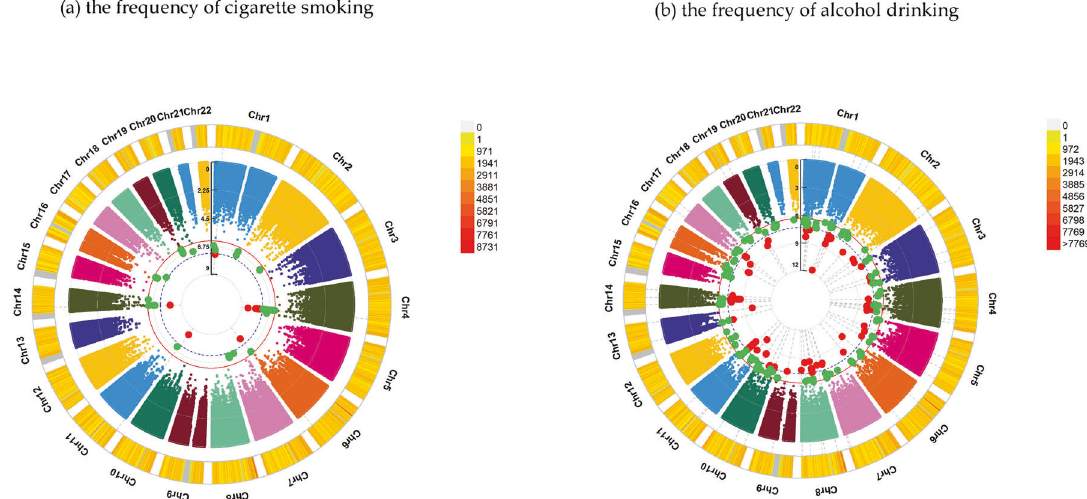
Fig. 3 Chromosomal regions interacting with felt loved as a child for substance use. *From the center, the circos depicts the − log 10 P values of each variant. Red plots represent the P value < 5 × 10 − 8 and green plots represent P value < 5 × 10 − 7 . The plots were generated using the “ CMplot ” R script (https://github.com/YinLiLin/R-CMplot).